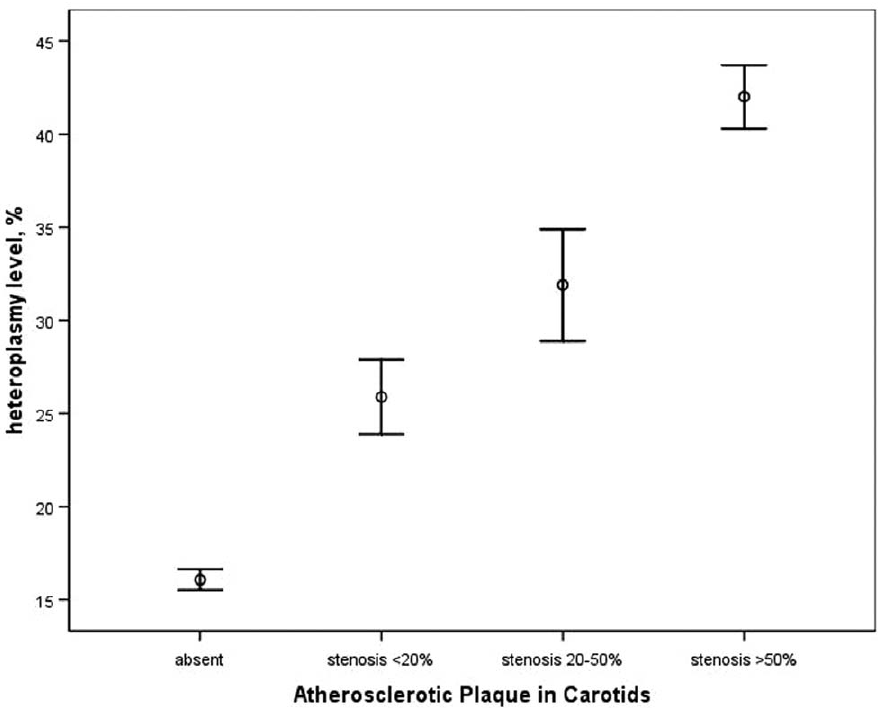
Figure 2. Graph showing the association of the level of C3256T heteroplasmy of mitochondrial DNA from white blood cells with the size of carotid atherosclerotic plaque. The data are presented as mean values and S.E.M.